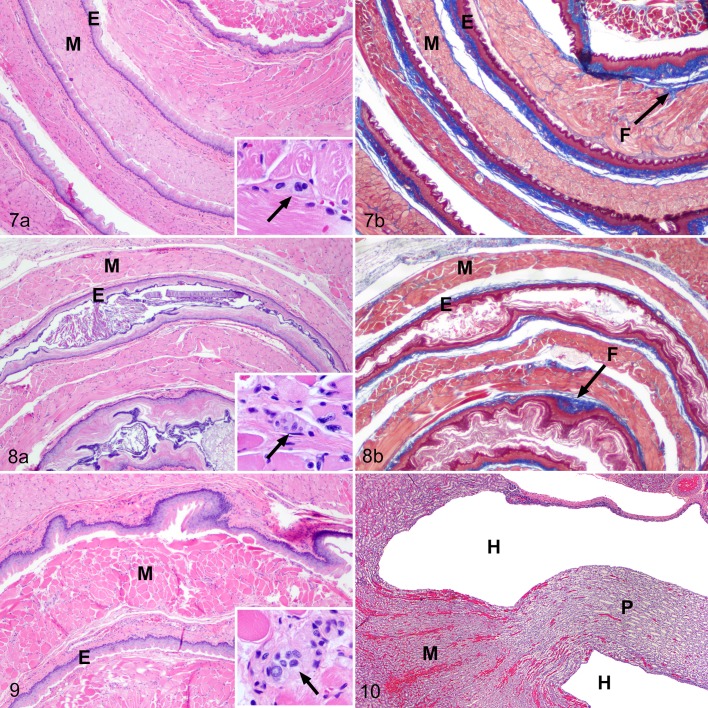
Esophageal Swiss rolls from rats of varying Rbm20
genotypes. Figure 7 is from a 52-week-old Rbm20–/– rat without megaesophagus, Figure 8 is from a
60-week-old Rbm20–/– rat with megaesophagus,
and Figure 9 is from a 64-week-old Rbm20+/+ rat
without megaesophagus. In each case, all layers of the esophagus are present in
appropriate ratios (a). Insets show normal ganglion cells (arrow) of the myenteric
plexus. Similar amounts of fibrosis (F, blue) are seen in the submucosal regions in both
the Rbm20–/– rat lacking megaesophagus (Fig.
7b) and the Rbm20–/– rat with megaesophagus
(Fig. 8b); a similar amount of fibrosis was also seen in the Rbm20+/+ rat (data not shown). A, Hematoxylin and eosin (HE).
B, Masson’s trichrome. E, epithelium; M, muscularis. Figure 10. Hydronephrosis,
52-week-old Rbm20–/– rat with megaesophagus.
HE. H, dilated pelvis; M, medulla; P, papilla.